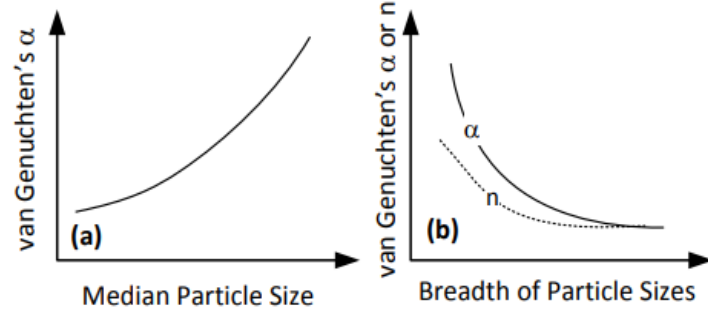
Figure 2: Conceptual diagram presenting the effect of (a) the median particle size of uniform sand, and (b) the breadth of particle size distribution, on the parameters α and n (Craig H. Benson et al.